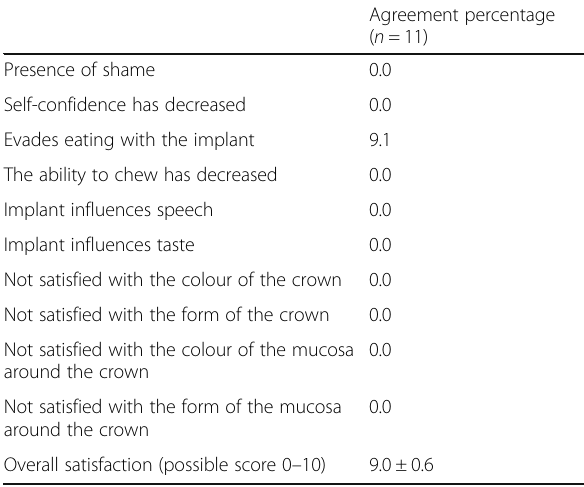
Table 5 Patient ’ s satisfaction 12 months (T 12 ) after